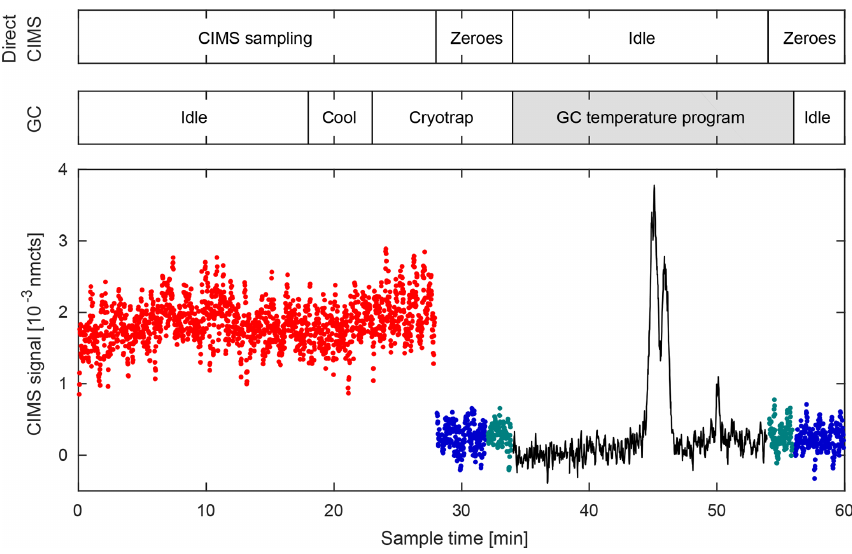
Figure 8. Typical GC–CIMS sampling cycle during the 2017 field study in Pasadena, CA. Data shown for m/z 232. Cycle has a period of 1h in which the first half is dedicated to direct CIMS measurements (red), and the latter half measures compound signals that have undergone chromatographic separation (black). The two sampling modes are separated by a zeroing period comprised of a 4min ambient zero (blue) and a 2min dry zero (green). Most GC processes occur in the background during direct sampling, so as not to interrupt data collection. Data shown here are a 2s average. Changes in the amount of flow entering the ion source during direct CIMS and GC–CIMS sampling directly correlate with the signal-to-noise ratio seen during each operating mode. The increased flow rate through the ion source during the GC sampling mode results in higher ion counts and an increased signal-to-noise